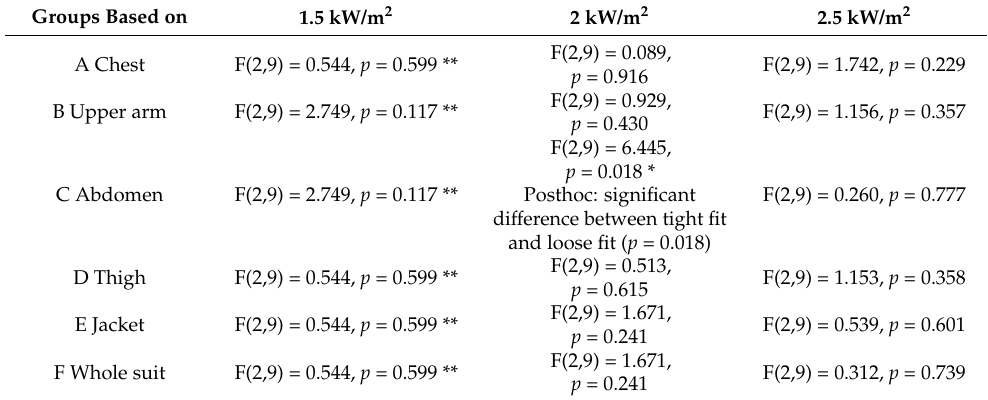
Table 7. Differences between tight, regular, and loose clothing fit group means in exposure time. Groups Based on